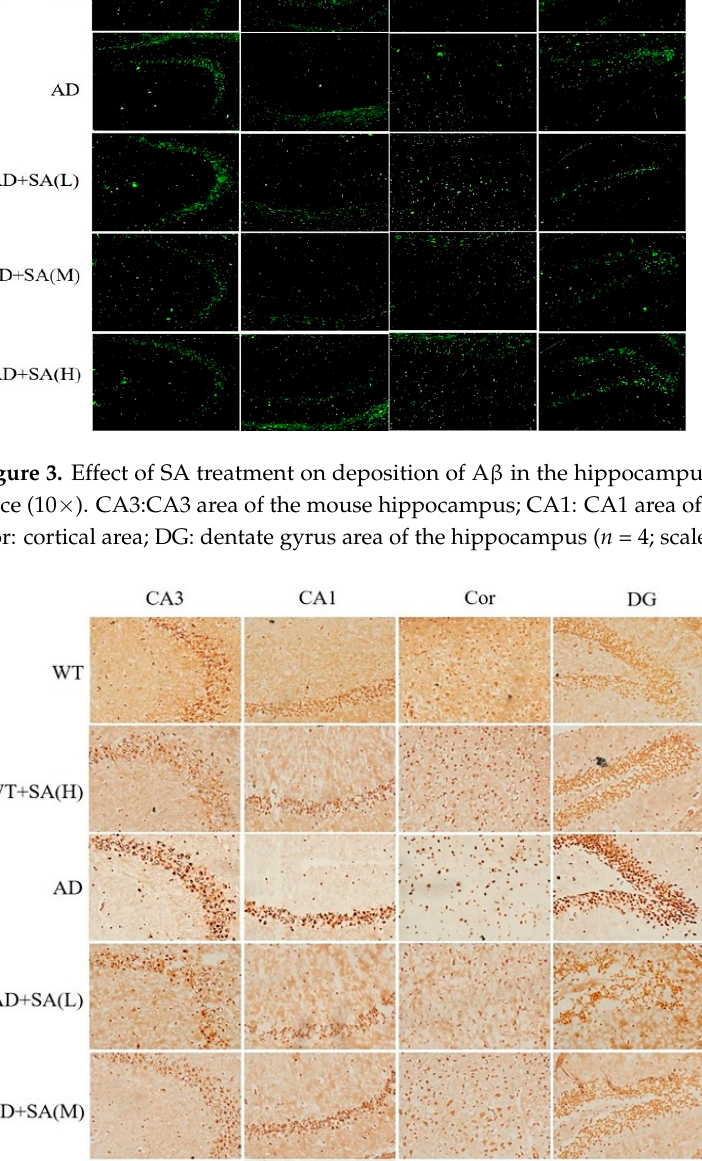
Figure 3. Effect of SA treatment on deposition of A β in the hippocampus and cortex of 2×Tg AD mice (10×). CA3:CA3 area of the mouse hippocampus; CA1: CA1 area of the mouse hippocampus;